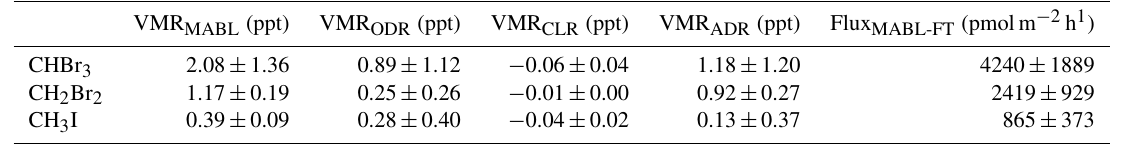
Table 4. Mean ± standard deviation of observed mixing ratios in the MABL on R/V Sonne (VMR MABL ) vs. the amount of VMR origi- nating from oceanic emissions (VMR ODR ) , chemically degraded according to the specific lifetime (VMR CLR ) , originating from advection (VMR ADR ) and the flux from the MABL into the FT (flux MABL-FT ) for CHBr 3 , CH 2 Br 2 and CH 3 I.